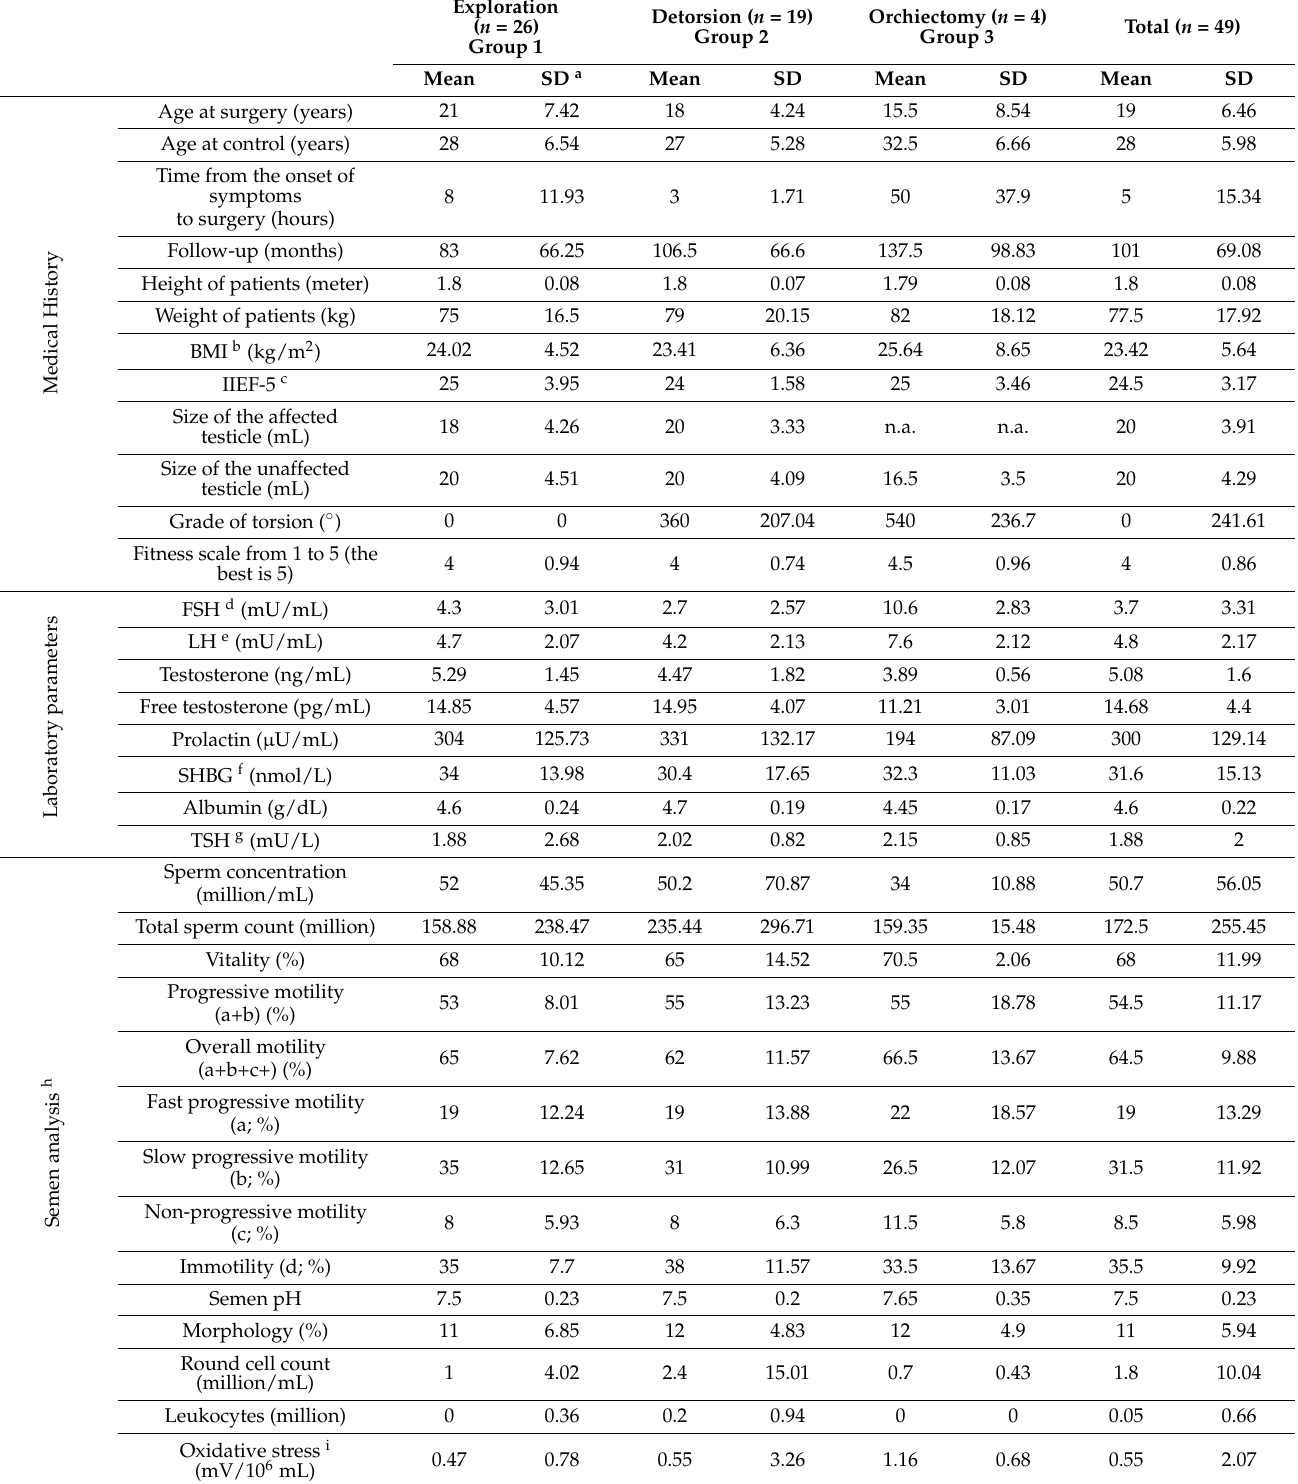
Table 2. Clinical data and laboratory